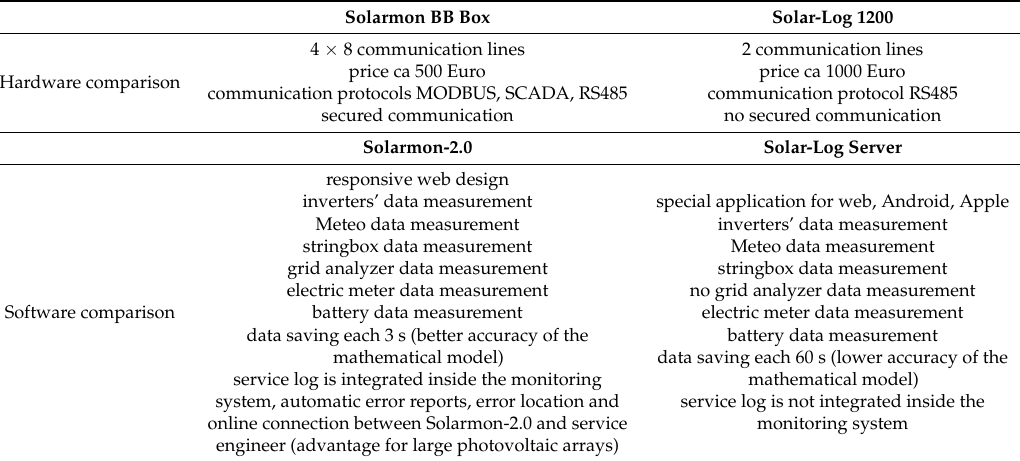
Table 3. Comparison of parameters between the widely-used monitoring system Solar-Log 1200 and the newly-developed system